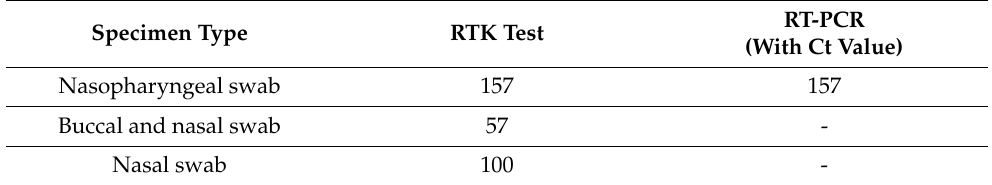
Table 1. Different types of clinical specimens used in current